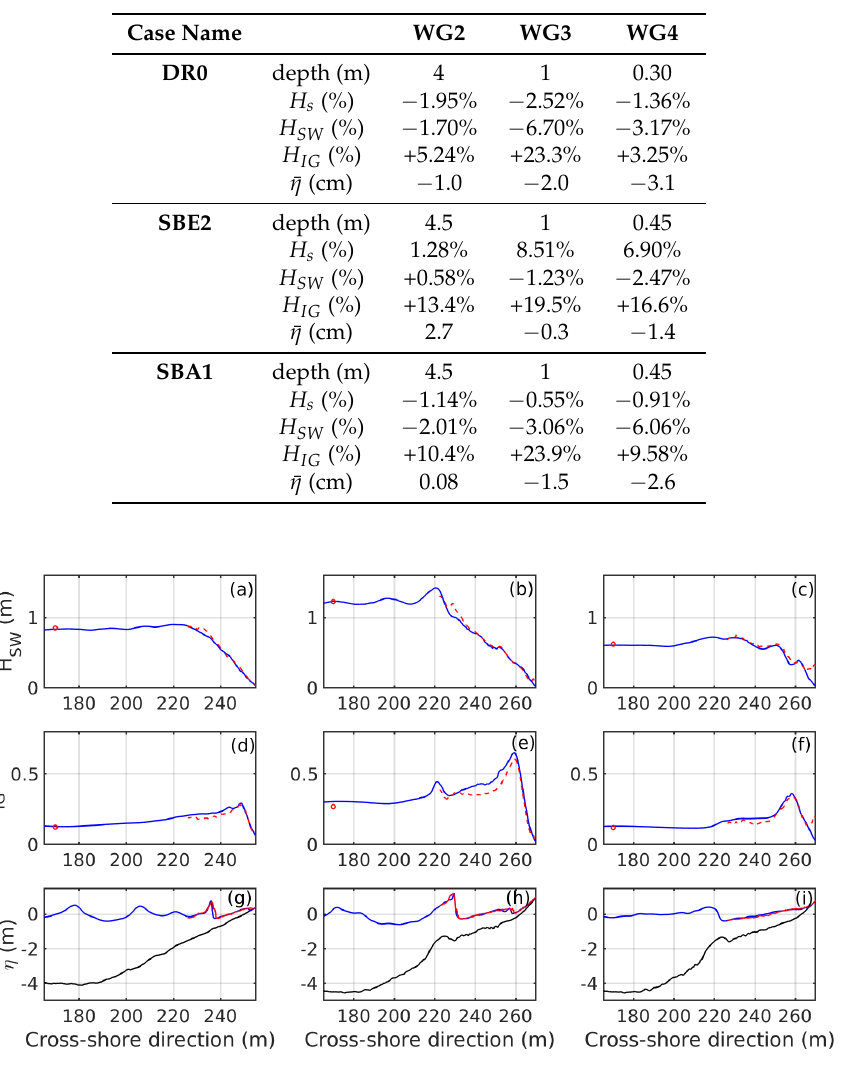
Figure 5. Cross-shore evolution of computed (blue solid line) and observed (red dashed lines) significant wave heights. Values at WG2 are shown as circles at x = 170 m. ( a – c ): H SW of cases DR0, SBE2, and SBA1. ( d – f ): H IG of cases DR0, SBE2, and SBA1. ( g – i ): bed profiles with modeled (blue) and LiDAR measurements (red) of the instantaneous free surface at t = 961